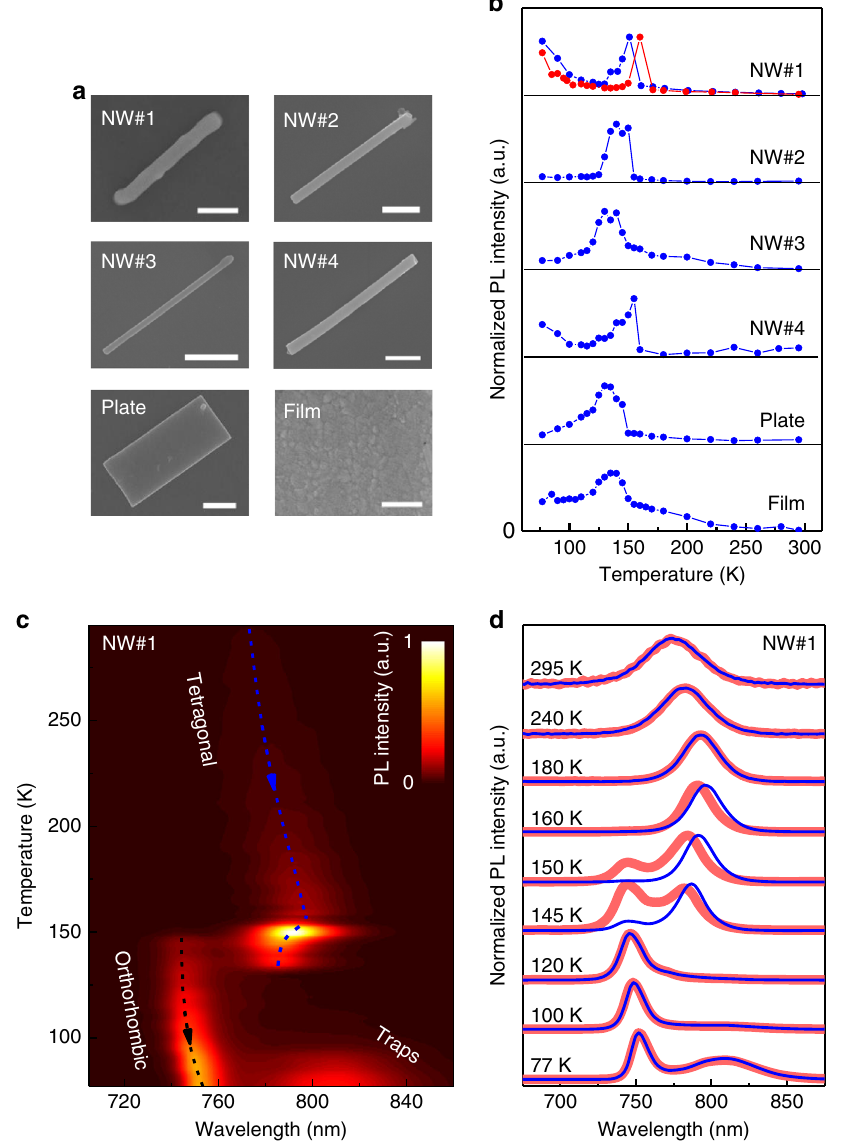
Fig. 1 Methylammonium lead triiodide perovskite samples and their temperature-dependent PL. SEM and temperature-dependent PL of individual methylammonium lead triiodide perovskite NWs (NW#1, NW#2, NW#3, NW#4), microplate, and a fi lm. a SEM images of the different samples; the scale bar is 1 μ m. b Variation of the normalized spectrally integrated PL intensity of the samples under cooling and heating ( blue circles and red circles , respectively). c 2D map (data were interpolated) of PL spectrum vs. temperature under cooling for NW#1. The dashed lines show the evolution of the emission peaks with temperature. d Normalized PL spectra of NW#1 at different temperatures during cooling ( blue lines ) and heating ( red lines ). PL spectra are vertically shifted for